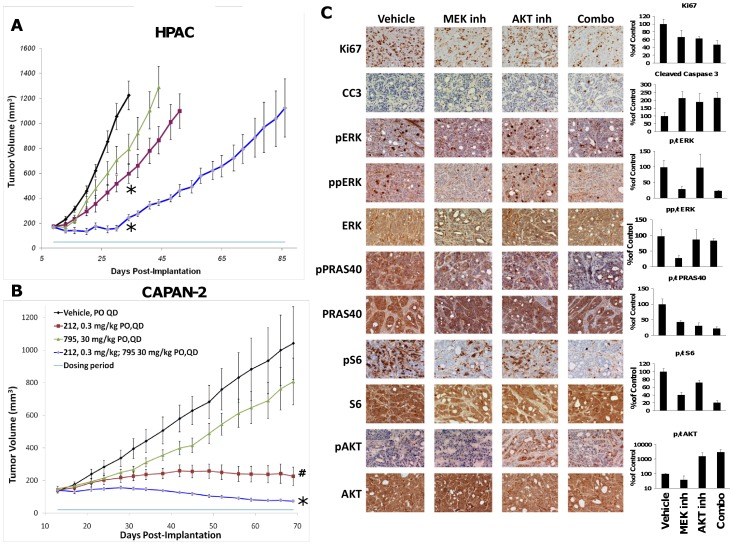
Combination anti-tumor effect of AKT and MEK inhibitors in mouse models of pancreatic cancer.Mice bearing HPAC (A) or CAPAN-2 (B) tumor xenografts were treated with either vehicle (black line), 0.3 mg/kg GSK1120212 (purple line), 30 mg/kg GSK2141795 (green line) or the combination of both (blue line). Data represents mean ± SEM. #p<0.05, *p<0.01. C, Immunohistochemical evaluation of HPAC tumor xenografts treated with vehicle, GSK1120212 at 0.3 mg/kg QDx3 (MEK inh), GSK2141795 at 30 mg/kg QDx3 (AKT inh) or the combination of GSK1120212 plus GSK2141795 at 0.3 and 30 mg/kg, respectively (combo). Tumor tissues were stained with markers of proliferation (Ki67), apoptosis (Cleaved Caspase 3; CC3), MAPK pathway activation (phospho-ERK, dually phospho-ERK and total ERK) and AKT pathway activation (phospho-PRAS40, total PRAS40, phospho-S6 kinase, total S6K, phospho-AKT and total AKT). Quantitative image analysis of various immune-staining is represented as a percentage of the vehicle control (100%). Data represents mean ± s.d.